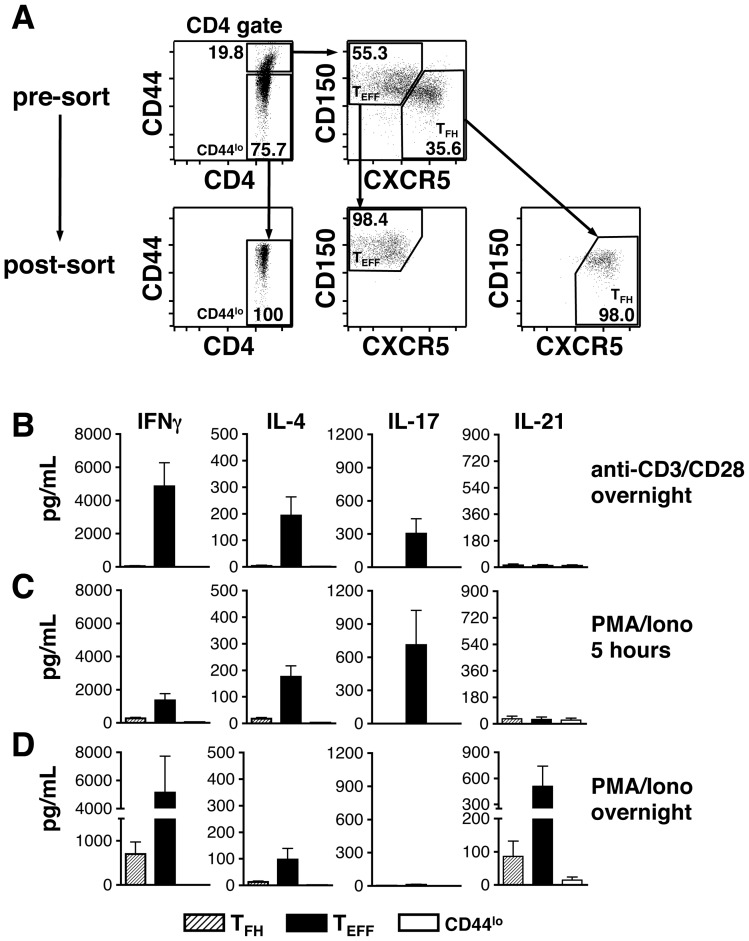
Cytokine production by IAV-induced TEFF and TFH cell populations.Animals were infected i.n. with a 0.1LD50 dose of IAV on day 0. dLNs were harvested on day 12 post-infection and stained with anti-CD4, anti-CD44, anti-CXCR5 and anti-CD150 mAbs. The CD4+CD44hiCXCR5−CD150hi (TEFF), CD4+CD44hi CXCR5+CD150lo (TFH) and CD4+CD44lo (CD44lo) populations were sort-purified and stimulated in vitro with anti-CD3 and anti-CD28 mAbs (18 hours) or with PMA and ionomycin (5 hours or 18 hours). Culture supernatants were then harvested and tested for IFNγ, IL-4, IL-17A, and IL-21 protein levels using cytokine bead array kits. A) Representative plots show the pre-sort and post-sort CD44lo, TEFF and TFH subsets. B) Cytokine production after overnight culture with plate bound anti-CD3 and anti-CD28 mAbs. C) Cytokine production after 5 hour culture with PMA and ionomycin. D) Cytokine production after overnight culture with PMA and ionomycin. Each bar represents mean ± SEM. n = 6 mice. Note that y-axes are identical vertically rather than horizontally in panels B–D.